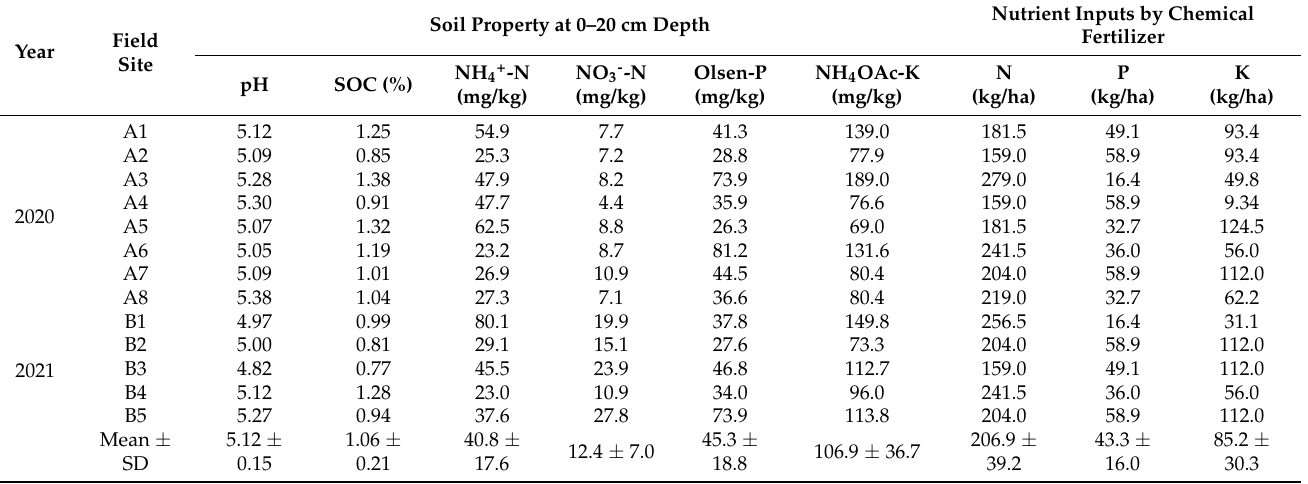
Table 1. Basic soil physiochemical properties and inputs of chemical fertilizers by the farmers’ prac- tice (FP) at different field sites in 2020 and 2021.